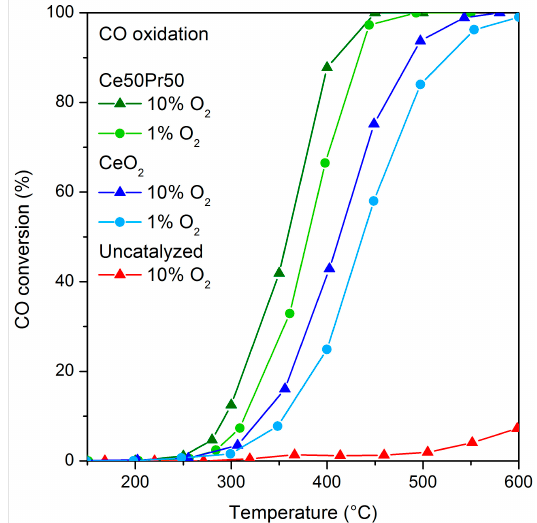
Figure 7. CO to CO 2 conversion as a function of the temperature, obtained testing pure CeO 2 and the Ce50Pr50 catalyst in different oxygen conditions.